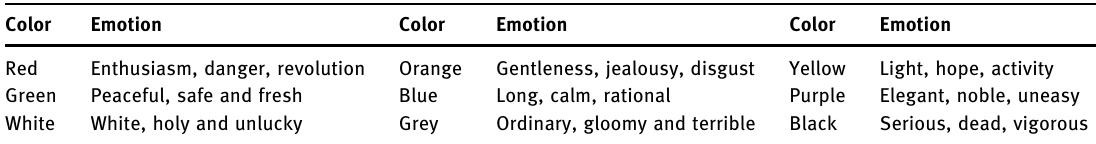
Table 1: The relationship between emotion and color Color Emotion Color Emotion Color Emotion Red Enthusiasm, danger, revolution Orange Gentleness, jealousy, disgust Yellow Light, hope, activity Green Peaceful, safe and fresh Blue Long, calm, rational Purple Elegant, noble, uneasy White White, holy and unlucky Grey Ordinary, gloomy and terrible Black Serious, dead,